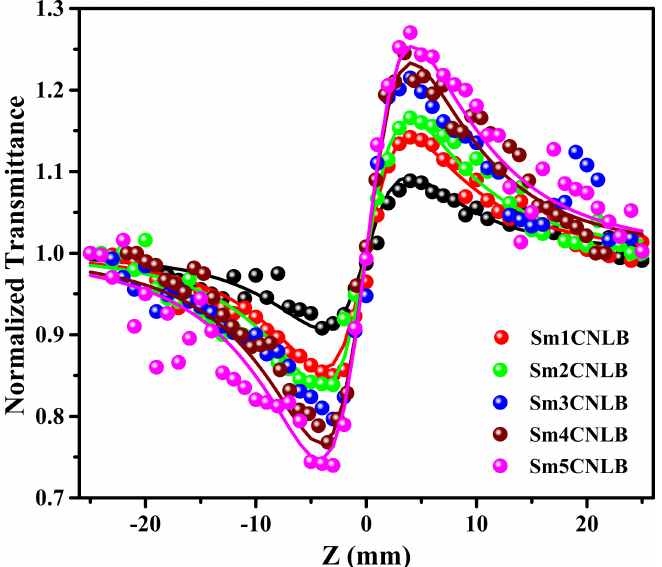
Figure 4. CA Z-scan profiles of studied Sm x CNLB glasses, where x = 0, 1, 2, 3, 4, and 5 mol %. The symbols and thick lines indicate the experimental and theoretical CA Z-scan data